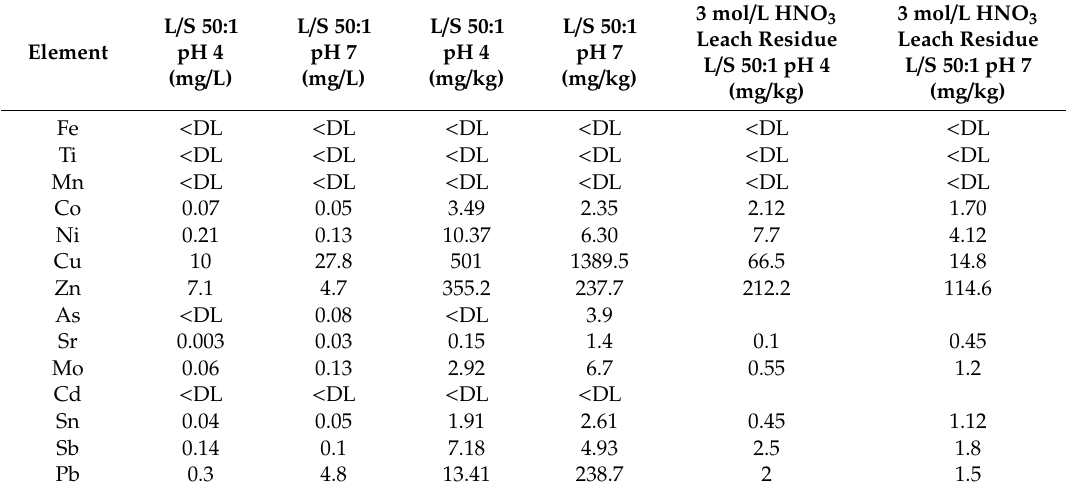
Table 5. NEN 7341 results for its original copper slag and its residue after 3 mol / L HNO 3 leaching.